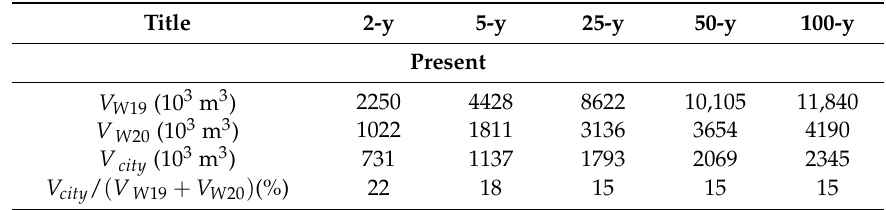
Figure 10. Comparison between the simulated and predicted runoff volumes on watershed scale. Table 12. Comparison of runoff simulated under different land-use scenarios on watershed and city scales.